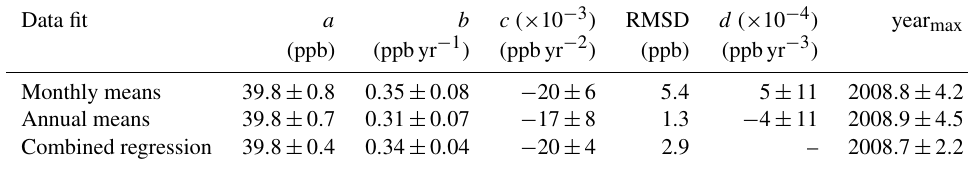
Table 1. Parameter values of fits of long-term change in Mace Head, Ireland, ozone data to Eq.